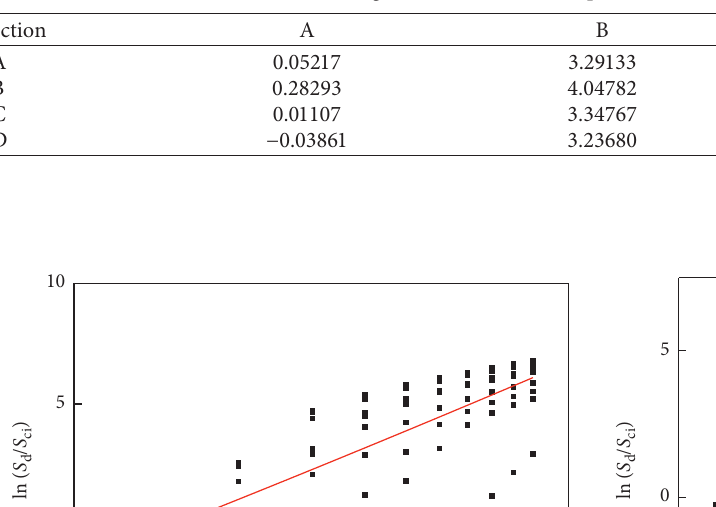
Table 5: The regression coefficients of pier 1 under longitudinal seismic